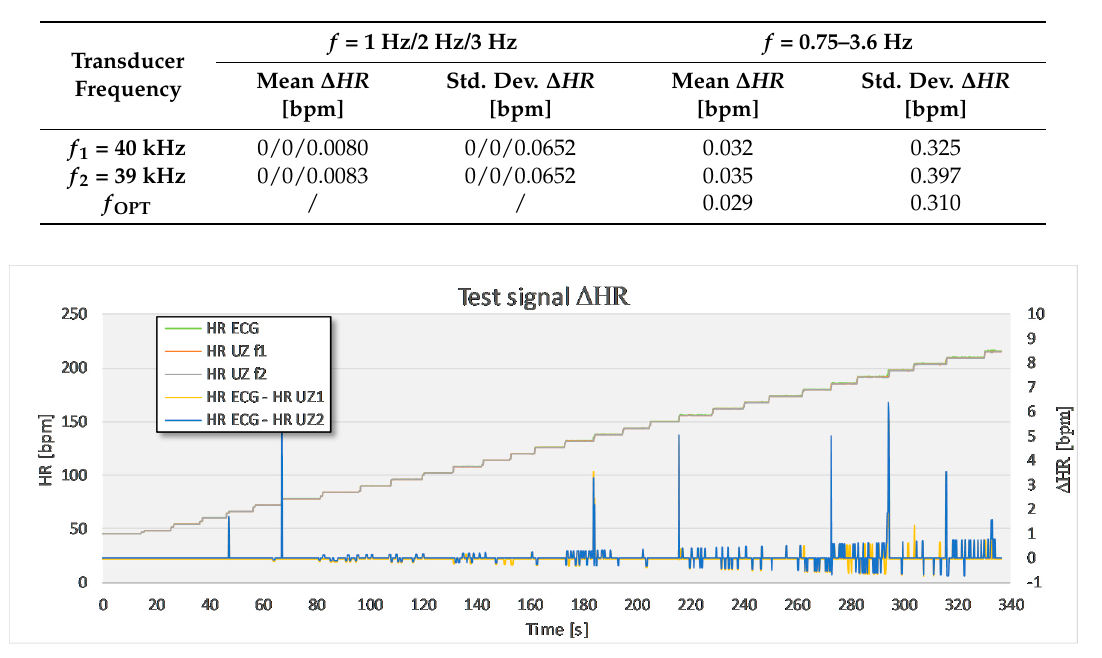
Figure 6. A comparison between the test signal, which is increased from 0.75 Hz (45 bpm) up to 3.6 Hz (216 bpm) in a random time interval, and the US signal. The largest deviations appear during the frequency change. Apart from that, the differences are kept below 1 bpm.